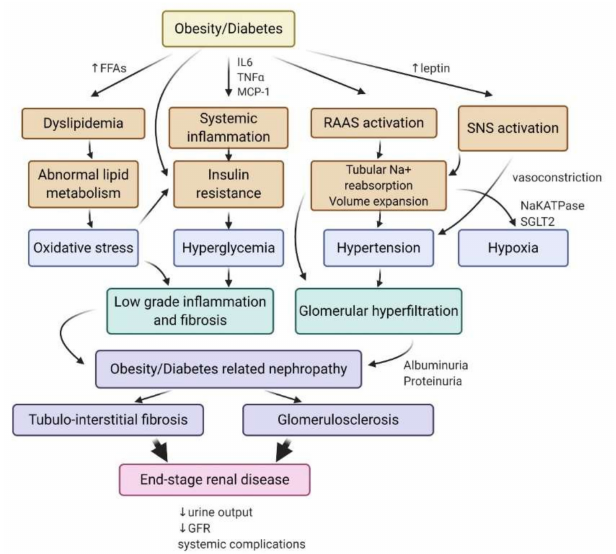
Figure 1. Mechanisms involved in the pathogenesis of diabetes- and obesity-related kidney disease and ultimately end-stage renal disease. Obesity and diabetes initiate systemic disturbances, including systemic inflammation, dyslipidemia, the activation of the SNS, and RAAS that contribute to intrarenal stresses resulting from abnormal lipid metabolism, insulin resistance, and tubular reabsorption of sodium. Hypertension and the associated glomerular hyperfiltration increase albuminuria. Renal oxidative stress and hyperglycemia lead to inflammation and fibrosis that initiate obesity- and diabetes-related nephropathy. Tubulo-interstitial fibrosis and glomerulosclerosis are associated with a progressive decline in the glomerular filtration rate (GFR), loss of nephrons, and ultimately end-stage renal disease. IL6, interleukin 6; TNF α , tumor necrosis factor- α ; MCP-1, monocyte chemoattractant protein-1; FFAs, free fatty acids; Na + -K + ATPase, sodium–potassium pump; SGLT2, sodium / glucose cotransporter 2; SNS, sympathetic nervous system; GFR, glomerular filtration rate; RAAS, renin–angiotensin–aldosterone